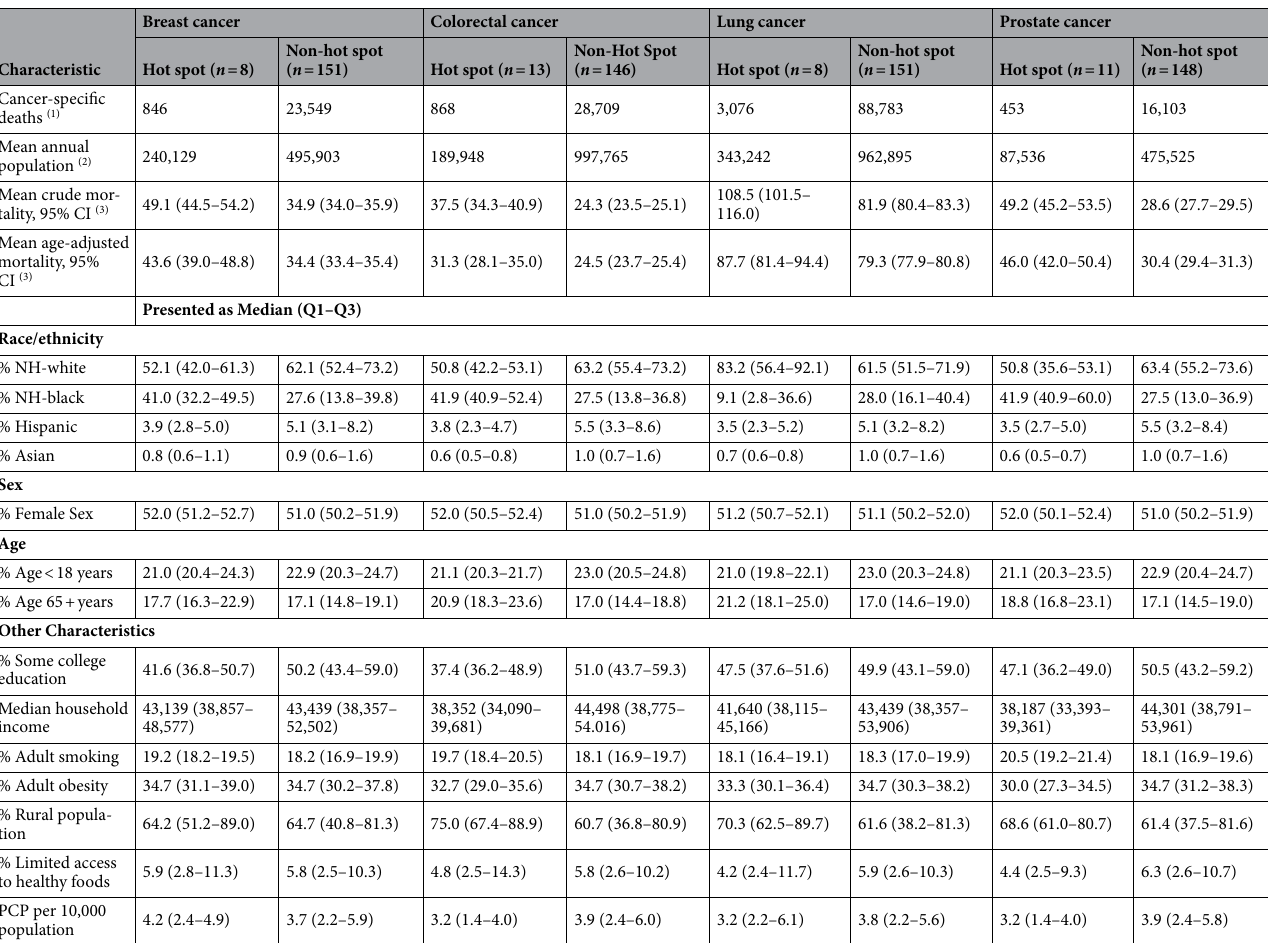
Table 1. Patterns of county-level community health risk factors and behaviors by cancer mortality hot spot classification, stratified by cancer types among all adults in Georgia 1999–2019. (1) Total number of cancer specific deaths from 1999 through 2019. (2) Mean annual population for total period (1999–2019) among counties within hot spot classification. For sex-specific cancers of breast and prostate, these mean population estimates are women and men, respectively. (3) Mortality rates are per 100,000 population. For sex-specific cancers of breast and prostate, they are per 100,000 women and men, respectively. 95% confidence limits presented with